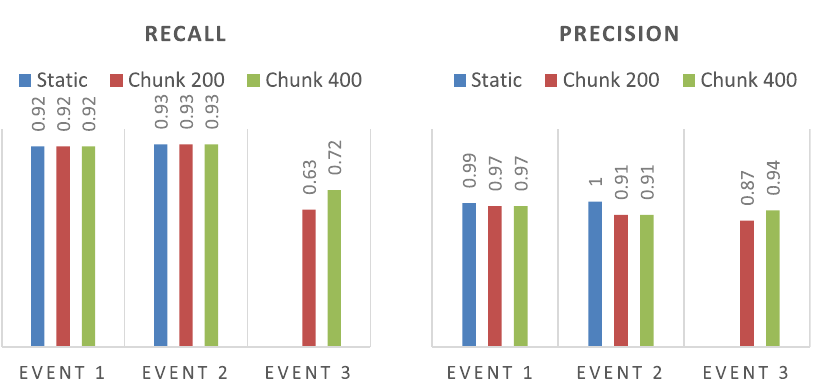
Fig. 11. Precision and Recall on